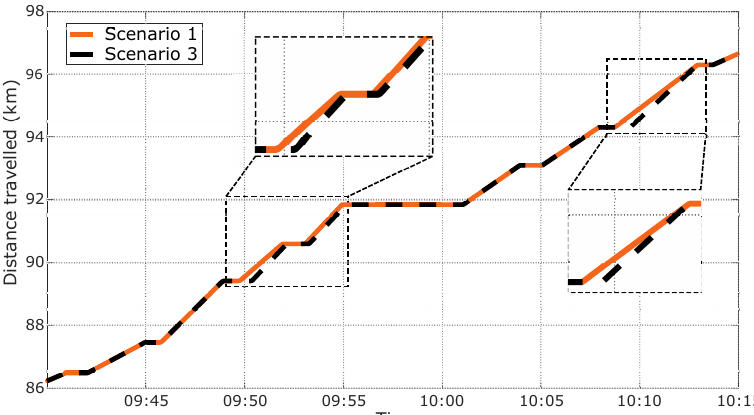
Figure 12. Comparison between the distance travelled by bus n°2 in scenario 1 and scenario 3. Figure 13 shows that the SoC of the 70 kWh battery of bus n°2 reaches 22.2% in scenario 3. This means that there is almost no security margin to ensure that the SoC will not fall below soc min in case of a higher consumption. The total energy consumption is 337 kWh—respectively, 140 kWh and 197 kWh for buses n°1 and 2—which represents an average consumption per travelled distance of 0.91 kWh/km.